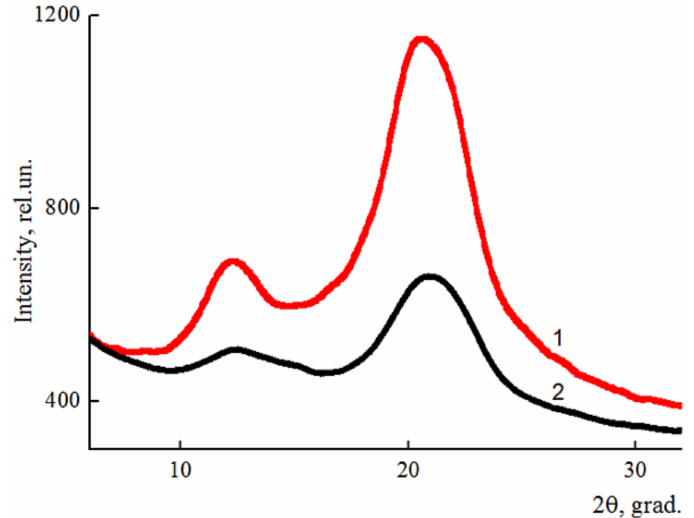
Figure 6. Equatorial diffractograms of cellulose (1) and composite (95% cellulose + 5% betulin) (2)